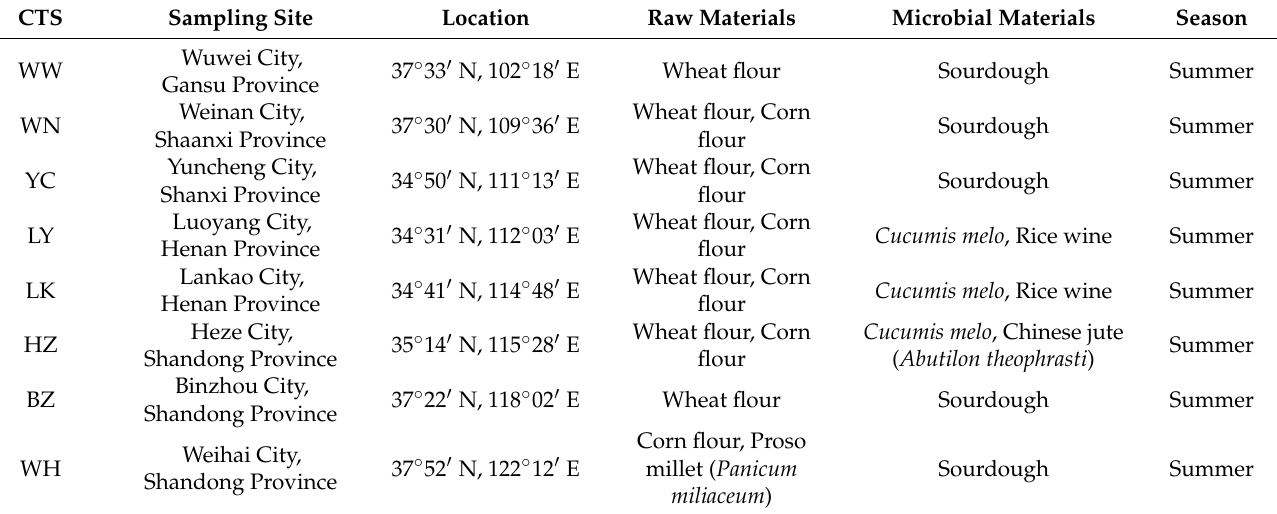
Table 1. Characteristics of CTSs sampled from different regions in